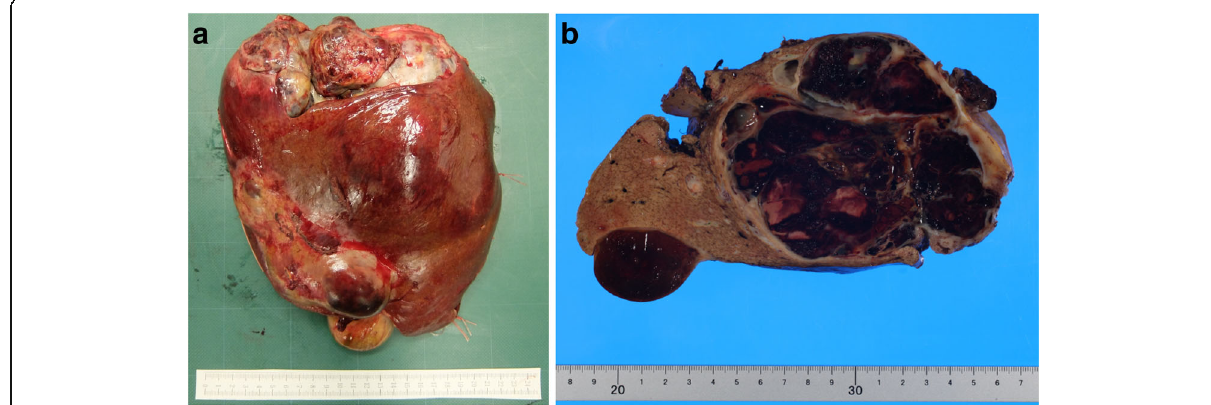
Fig. 3 Surgical specimen. Macroscopically, the tumor has a nodule with a black-brown and yellowish-white composition with septum formation on the cut